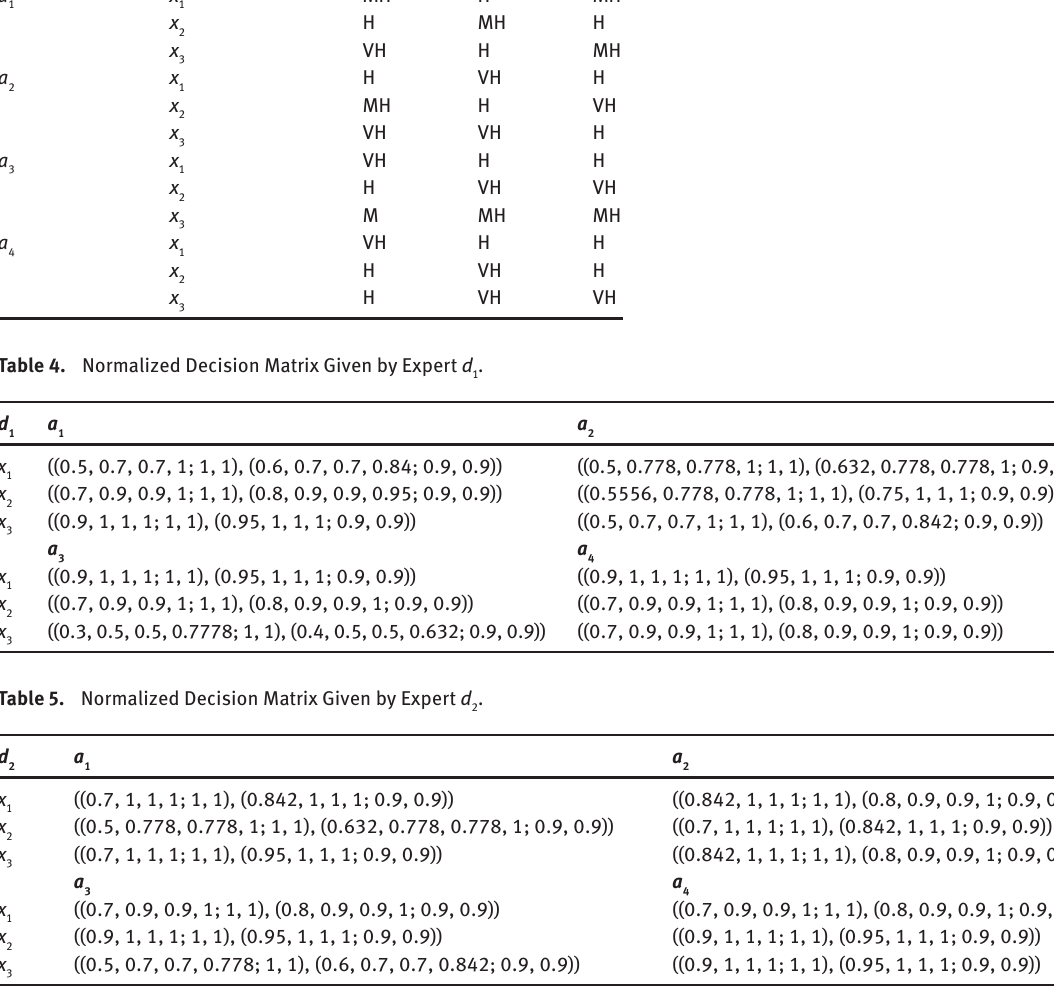
Table 3. Evaluating Values of the Alternatives Given by the Experts with Respect to Different Attributes.